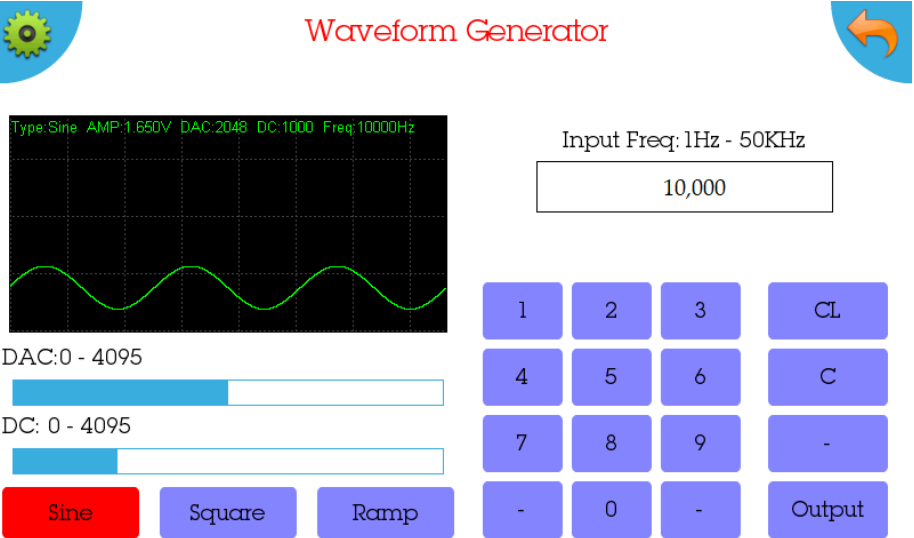
Figure 6. Screenshot of user-interface of the laser